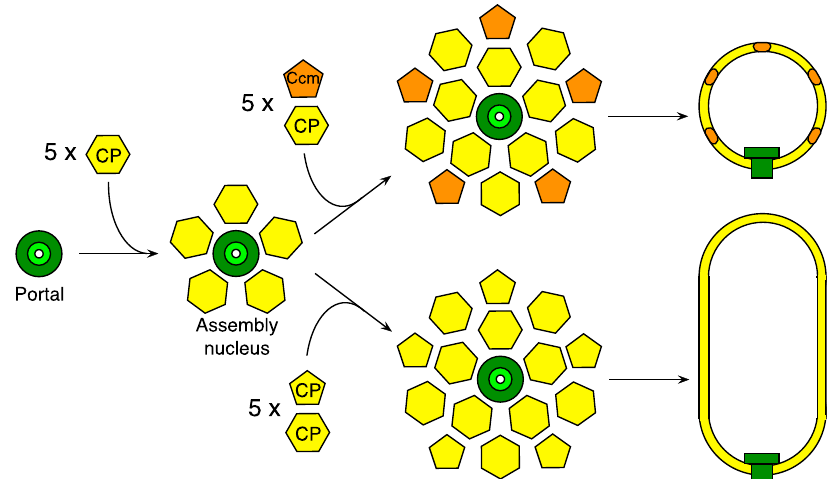
Fig. 8 Schematic diagram of the Ccm-induced size redirection. The initial step is the formation of an assembly nucleus consisting of the portal (green) and fi ve CP hexamers (yellow). If Ccm pentamers (orange) and CP hexamers are added to this nucleus, isometric capsids are formed; if both pentamers and hexamers of CP are used, prolate capsids result. Note that this should not be taken to imply that the capsid necessarily assembles through the addition of preformed pentamers and